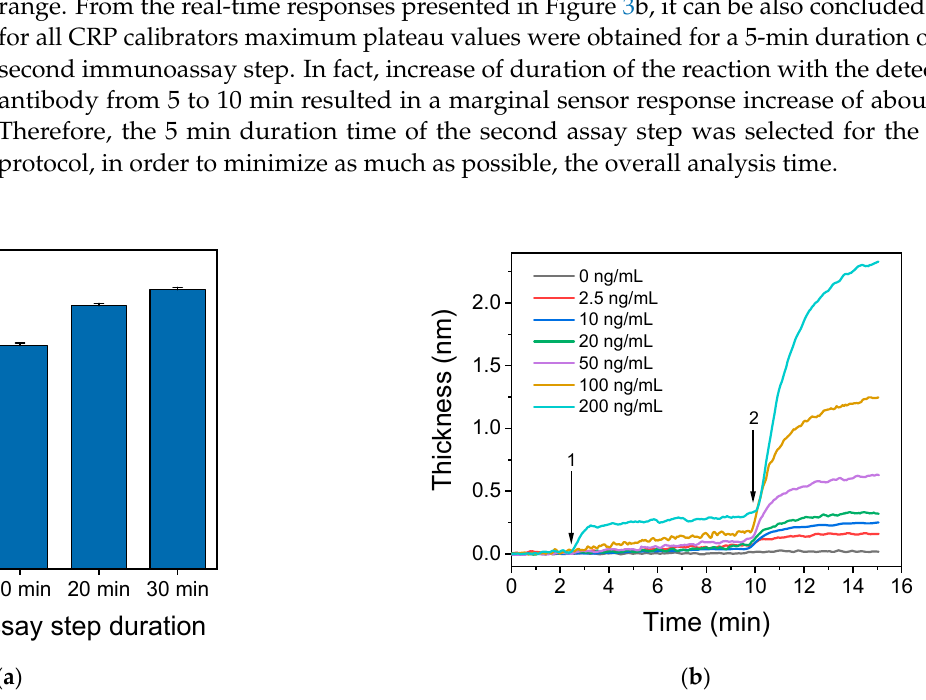
7 of 14 Figure 2. ( a ) Sensor responses obtained for a calibrator containing 100 ng/mL CRP using biochips coated with two different anti-CRP antibodies (GC019 or 6404) at a concentration of 100 μ g/mL in combination with four different detection anti- bodies all at a concentration 10 μ g/mL. Each point is the mean value of three measurements ± SD. ( b ) Sensor responses obtained for a calibrator containing 100 ng/mL CRP from chips coated with capture anti-CRP antibody at concentrations ranging from 20 to 400 μ g/mL. Each point is the mean value of three measurements ± SD. Once the capture and detection antibody concentrations were selected, the duration of each immunoassay step was determined. For this purpose, duration times of 5, 7, 10, 20